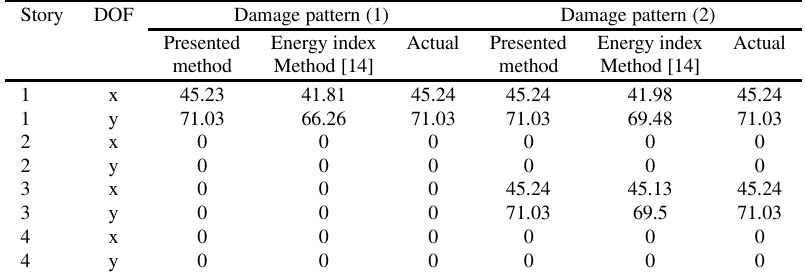
Table 3 Comparison of the results of the methods for damage detection of the benchmark structure